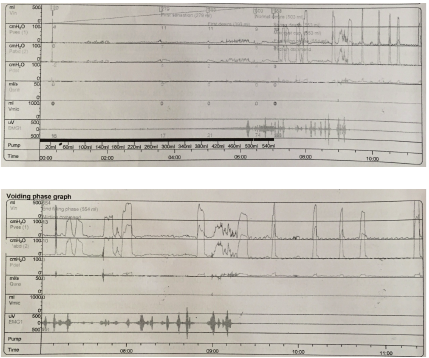
Figure 1: Pressure-flow study report: pretreatment.